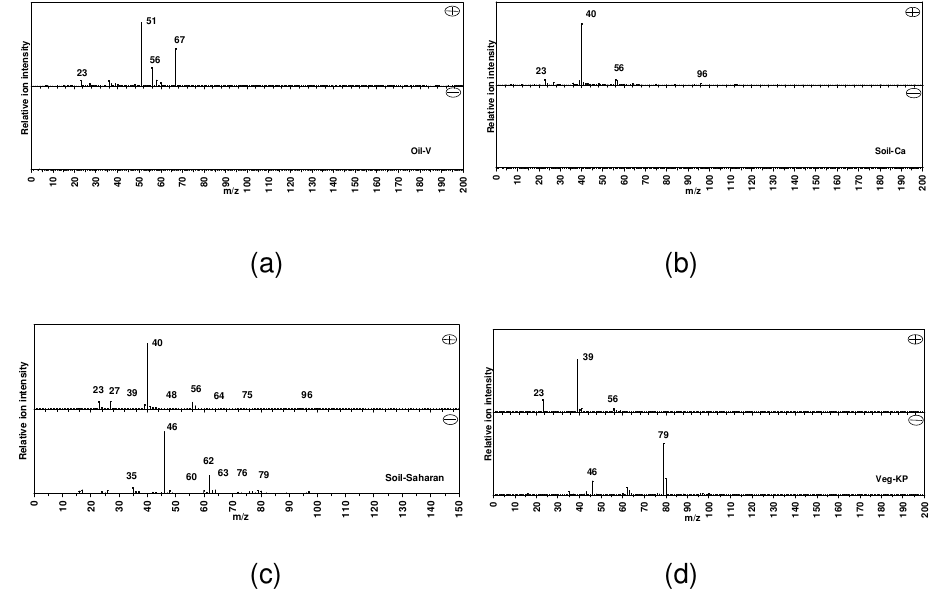
Figure 4. Average mass spectra of the four single-particle types only observed at the UB